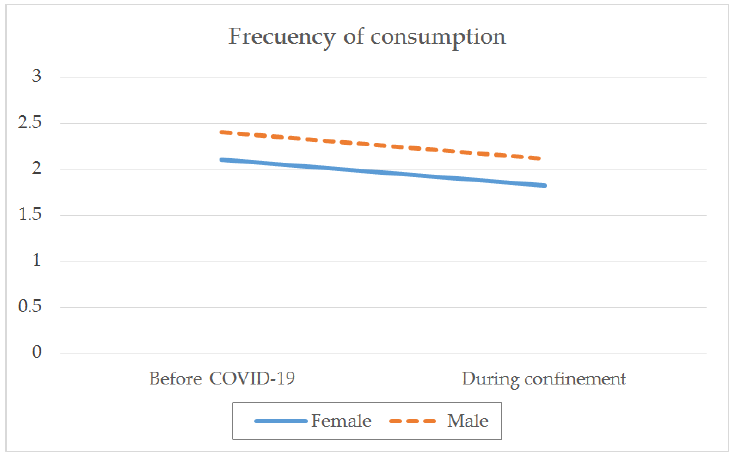
Figure 1. Average frequency of consumption by gender before the pandemic and during COVID-19 confinement.